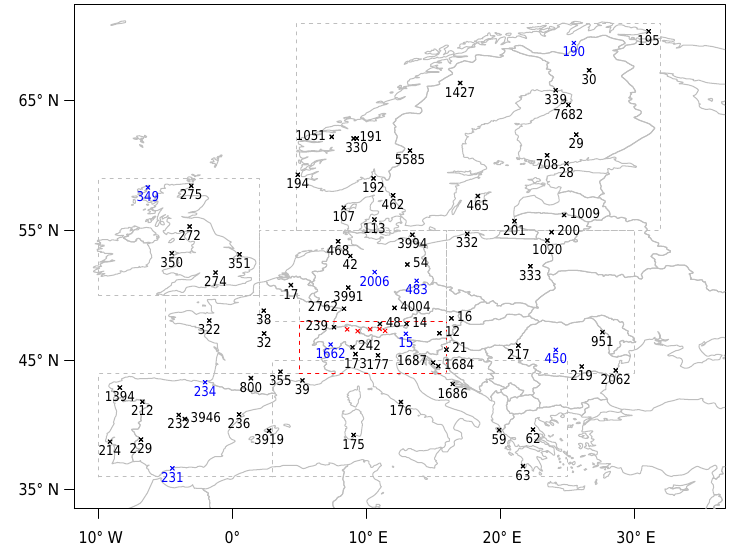
Figure 2. Location and IDs of used rain gauges from ECA&D. IDs of red marked stations from left to right: 244, 243, 4002, 58, and 13. Sta- tions for detailed analysis are marked in blue. Dashed lines represent European subdomains for analysis as defined by the PRUDENCE project (Christensen and Christensen, 2007): the British Isles (BI), the Iberian Peninsula (IP), France (FR), Mid-Europe (ME), Scandinavia (SC), the Alps (AL, dashed red line), the Mediterranean (MD), and eastern Europe (EA).